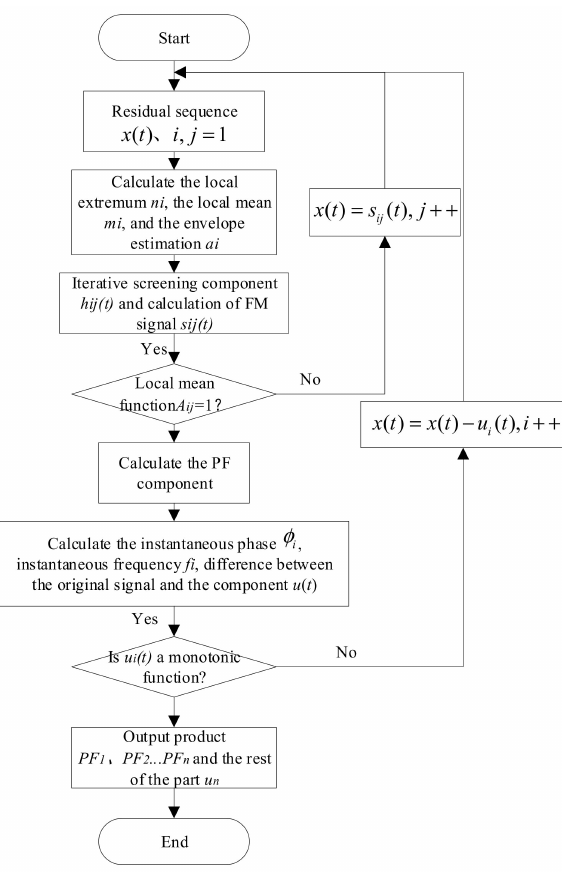
Figure 3. Flowchart of the LMD decomposition